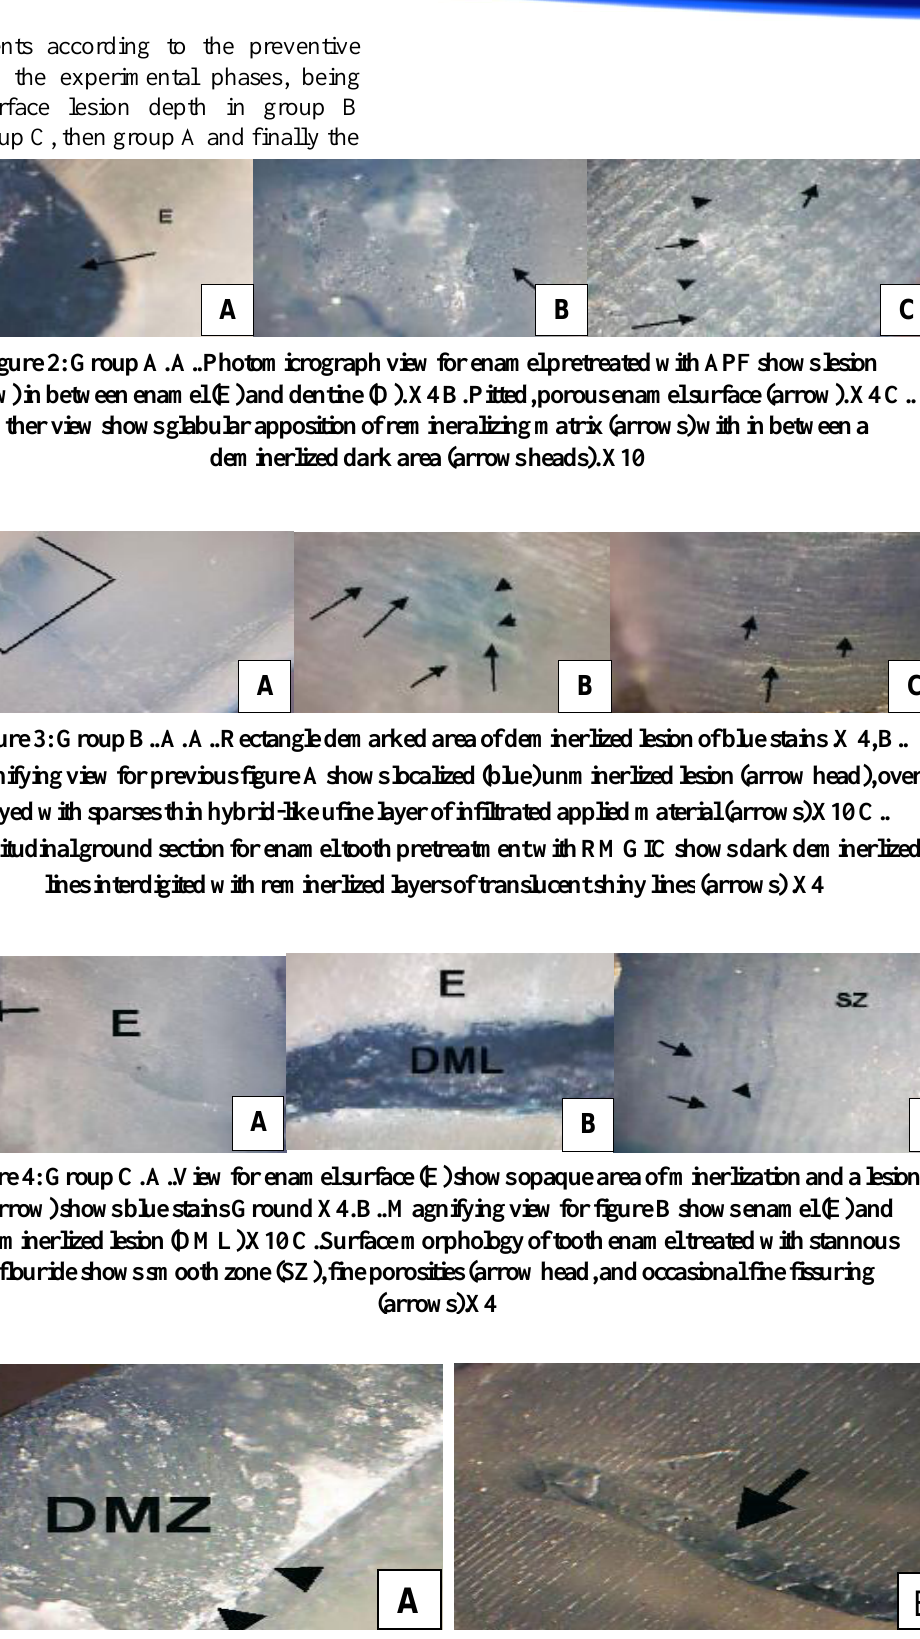
Figure 5: Group D . A. . Photomicrograph view for surface enamel of control group, showed dark demineralization zone extends to dentine enamel junction (arrow head). B.. longitudinal ground section shows extension of lesion (arrow) with rough pitted enamel.